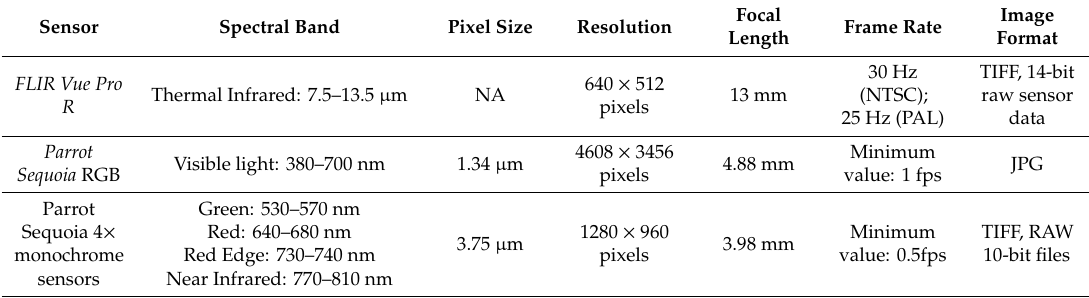
Table 1. Specifications of the FLIR Vue Pro and Parrot Sequoia sensors [50,51].